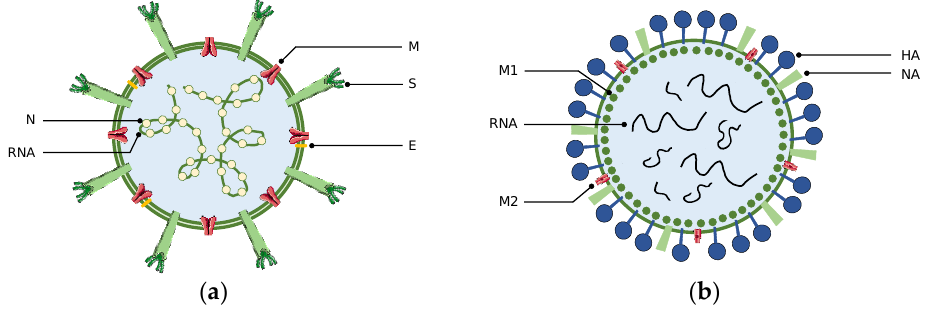
Figure 1. Schematic representation of ( a ) the coronavirus and its structural proteins (envelope (E), membrane (M), nucleocapsid (N) and spike surface glycoprotein (S)); and of ( b ) Influenza A and its membrane proteins (hemagglutinin (HA), neuraminidase (NA) and matrix (M)). SARS-CoV-2 (COVID-19) is very similar to the influenza virus (flu). In fact, both are Usually, IAV has three membrane proteins: NA, HA, and the matrix 2 (M2) [16]. The RNA viruses and present equivalent infectivity characteristics, including high incidence, matrix 1 (M1) is right under the membrane and is surrounded by eight viral RNA (Figure